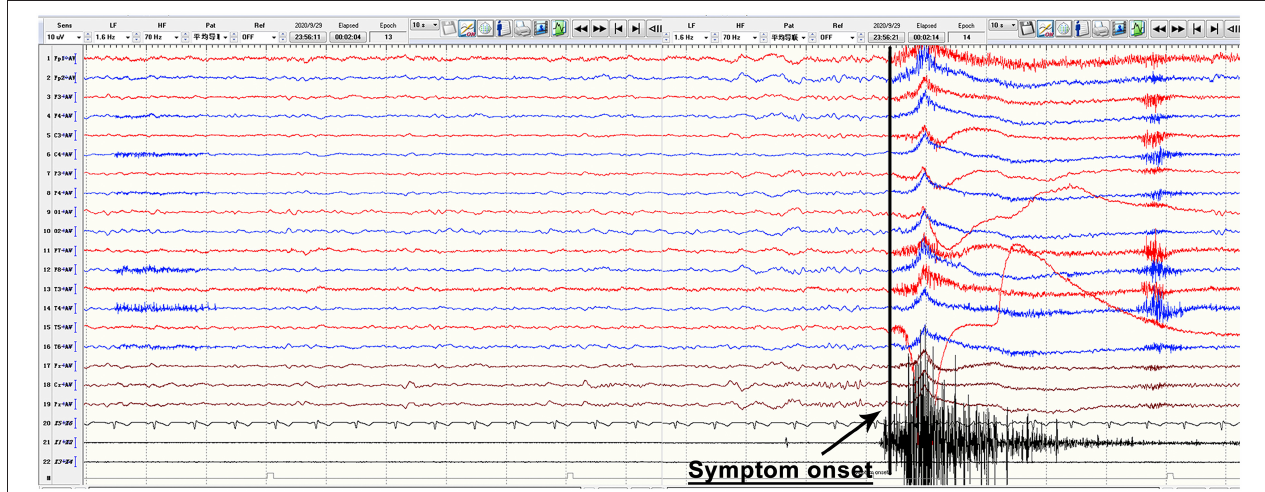
FIGURE 2 | Typical ictal EEG manifestations of FBDS. The figure is a continuous EEG recording. During the recording, this anti-LGI1 encephalitis patient had FBDS attacks, which manifested as repeated twitching of the left upper arm and the left corner of the mouth, and electromyography showed a burst on the left side when the FBDS appeared, while EEG showed no rhythm changes and only obvious movement artifacts. EEG, electroencephalography; FBDS, faciobrachial dystonic seizures; LGI1, leucine-rich glioma-inactivated protein